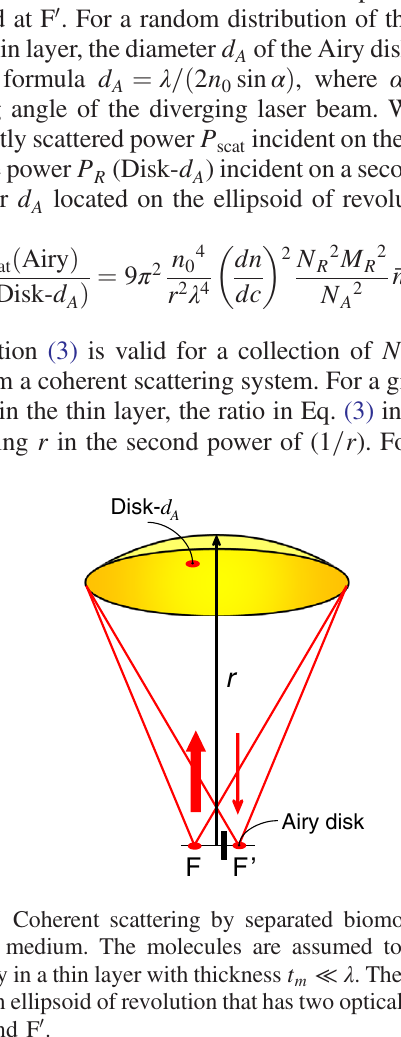
≪ λ . The layer forms a m